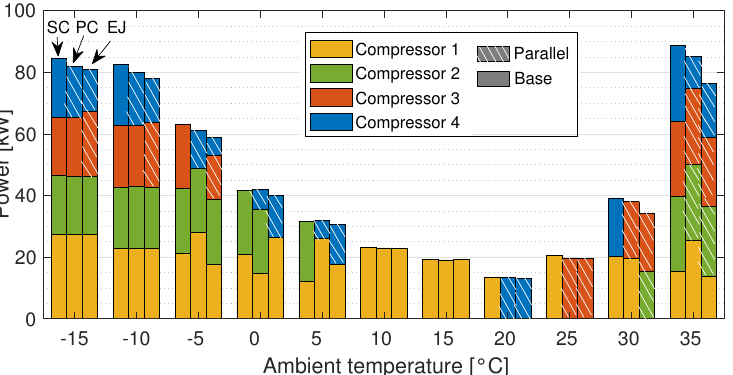
Figure 9. Electric power consumption and arrangement of the compressors when applying the leveled charging strategy. The three different bars at each temperature interval represents the designs of SC, PC, and EJ.